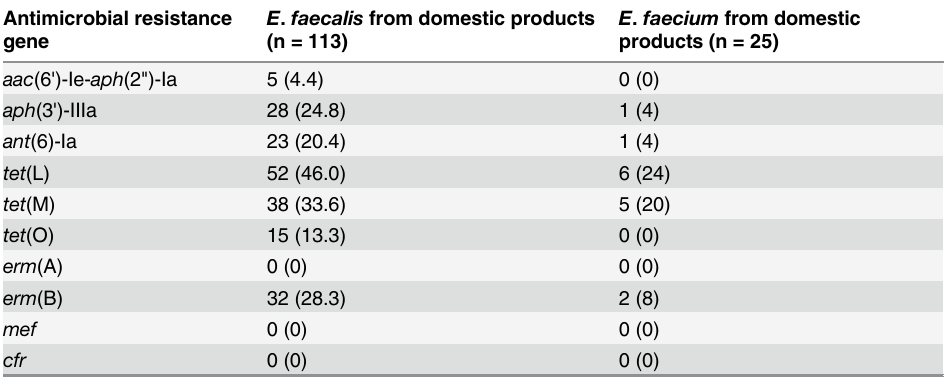
Prevalence of antimicrobial resistance genes tested among E . faecalis and E . faecium isolated from retail poultry products collected in 5 major Japanese cities between July and August